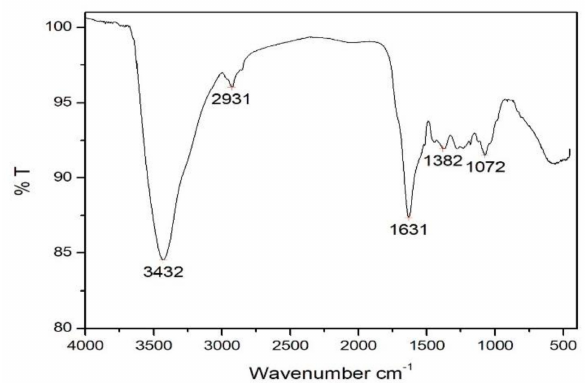
Figure 7. FTIR spectrum of the synthesized copper nanoparticles.